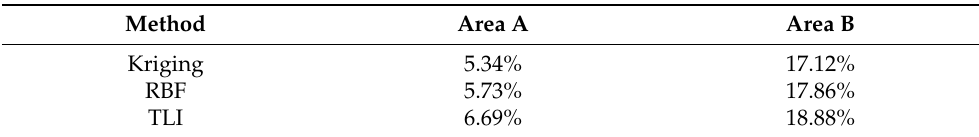
Table 1. The percentage of relative error between different interpolation results and the observed value.